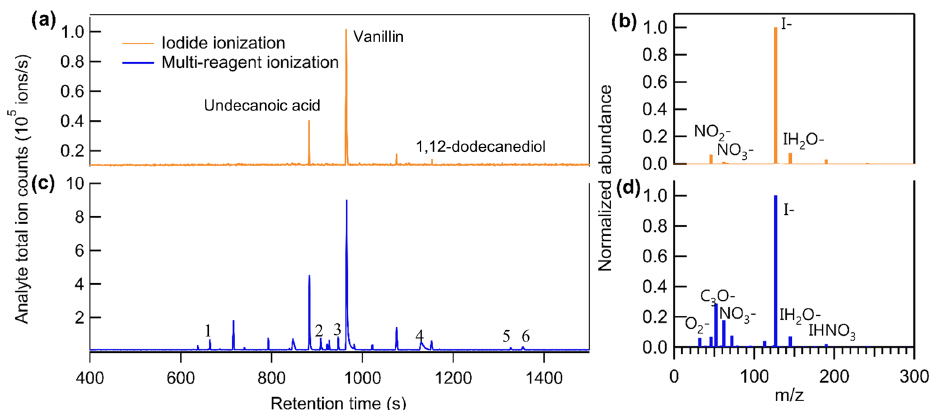
Figure 4. Comparison of chromatograms of analyte total ion counts between (a) iodide ionization and (c) multi-reagent ionization. Com- parison of background mass spectra between (b) iodide ionization and (d) multi-reagent ionization. The sample introduced in this run is the mixture of liquid chemical standards and six commercially available fragrances.